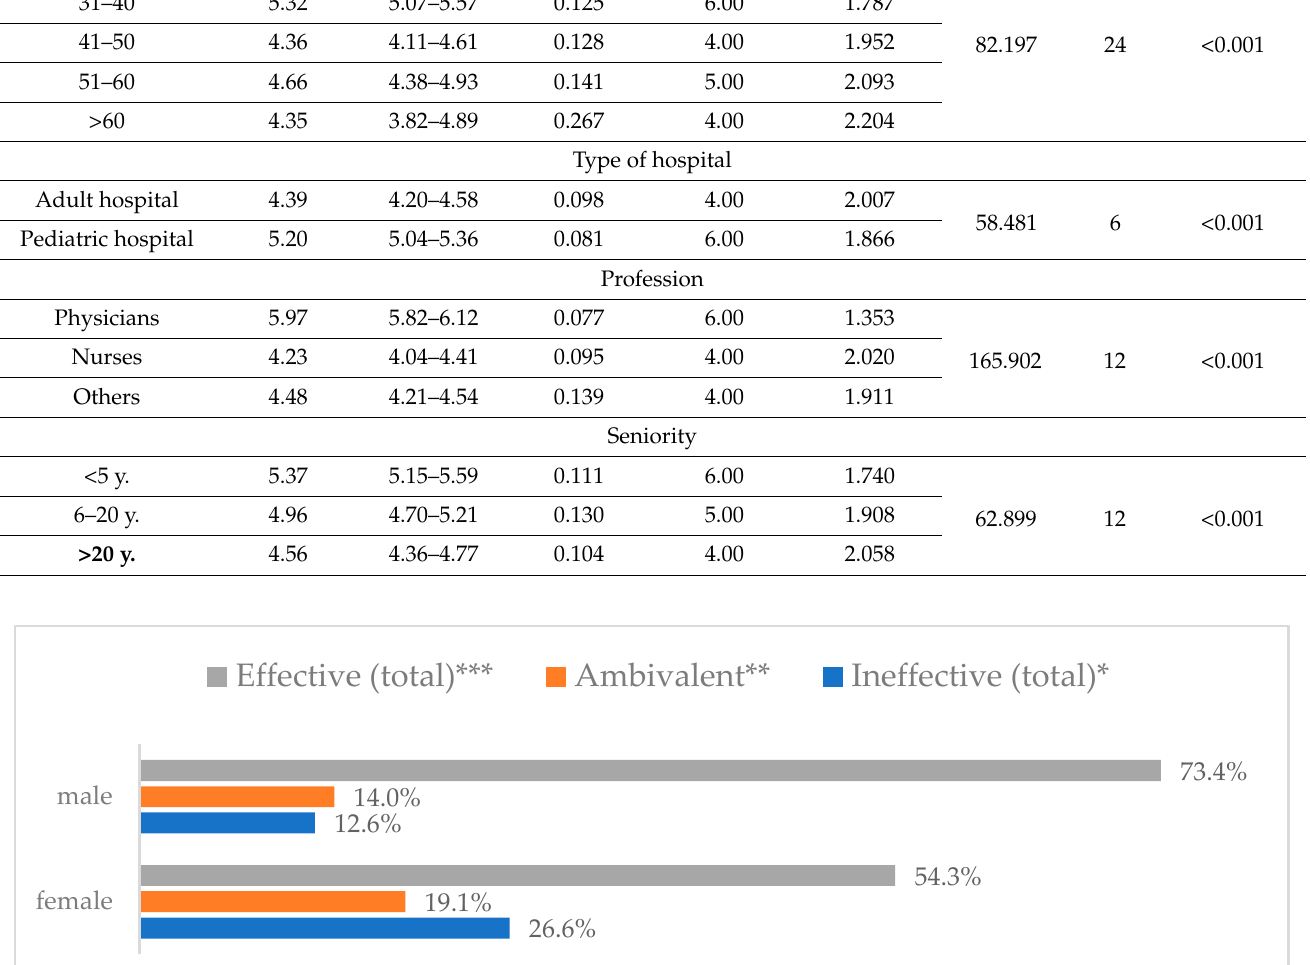
Figure 11. Influenza vaccination to prevent influenza virus infection by gender ( N = 905). *Sum of